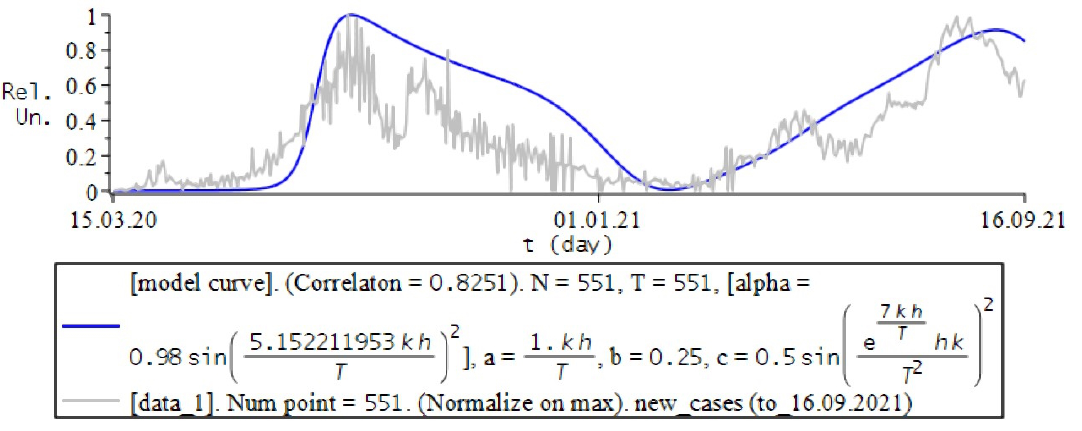
Figure 4. The result of executing the code to